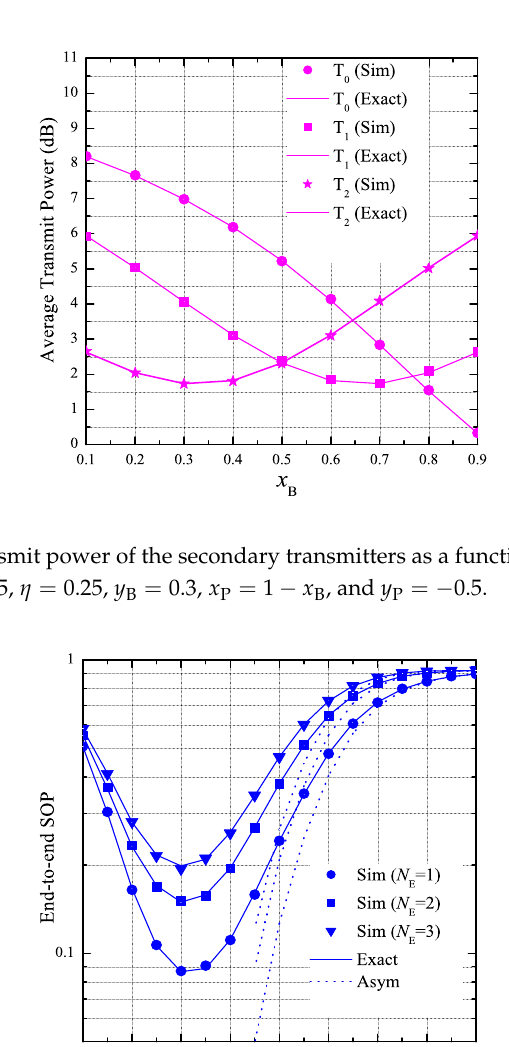
= 0.01, and κ 2 = D E